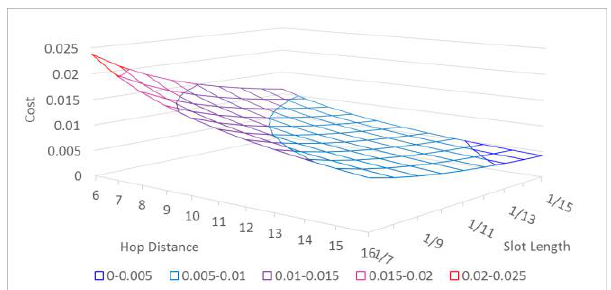
Figure 3. Cost varying the slot length and hop distance.